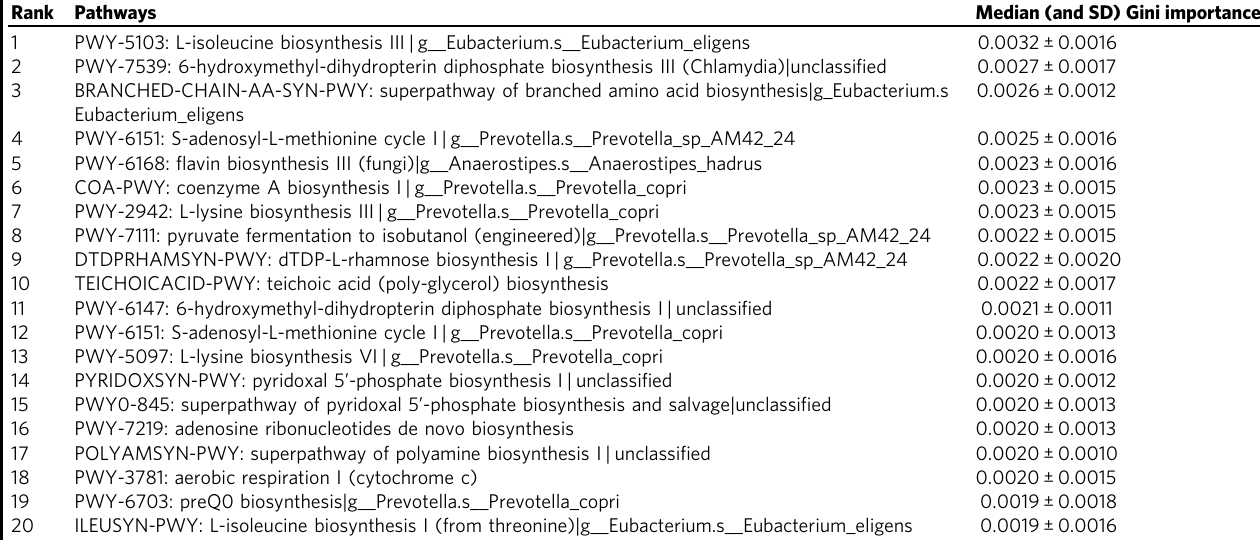
Table 2 Most important pathways to discriminate Nunavik gut microbiome composition from comparison groups, identi fi ed by random forest, ranked based on median Gini importance.